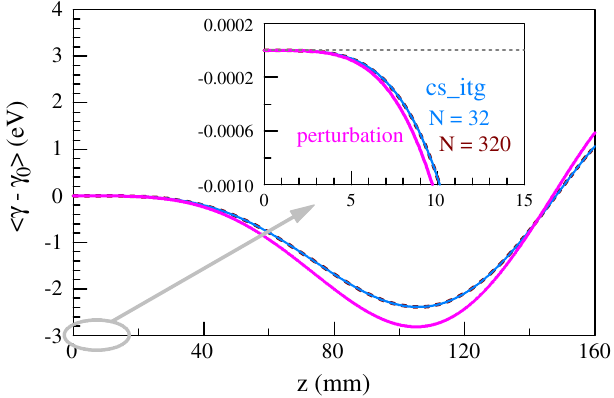
FIG. 24. (Color) (cs_itg method). Average energy increment i vs axial distance z for different particle numbers, h (cid:5) (cid:4) (cid:5) 0 with linear perturbation solution shown for comparison. It is seen that the curve for the 32-electron case exactly overlaps the one for the 320-electron case. The perturbation solution closely follows the curve obtained from the cs_itg method over a 160- mm distance.